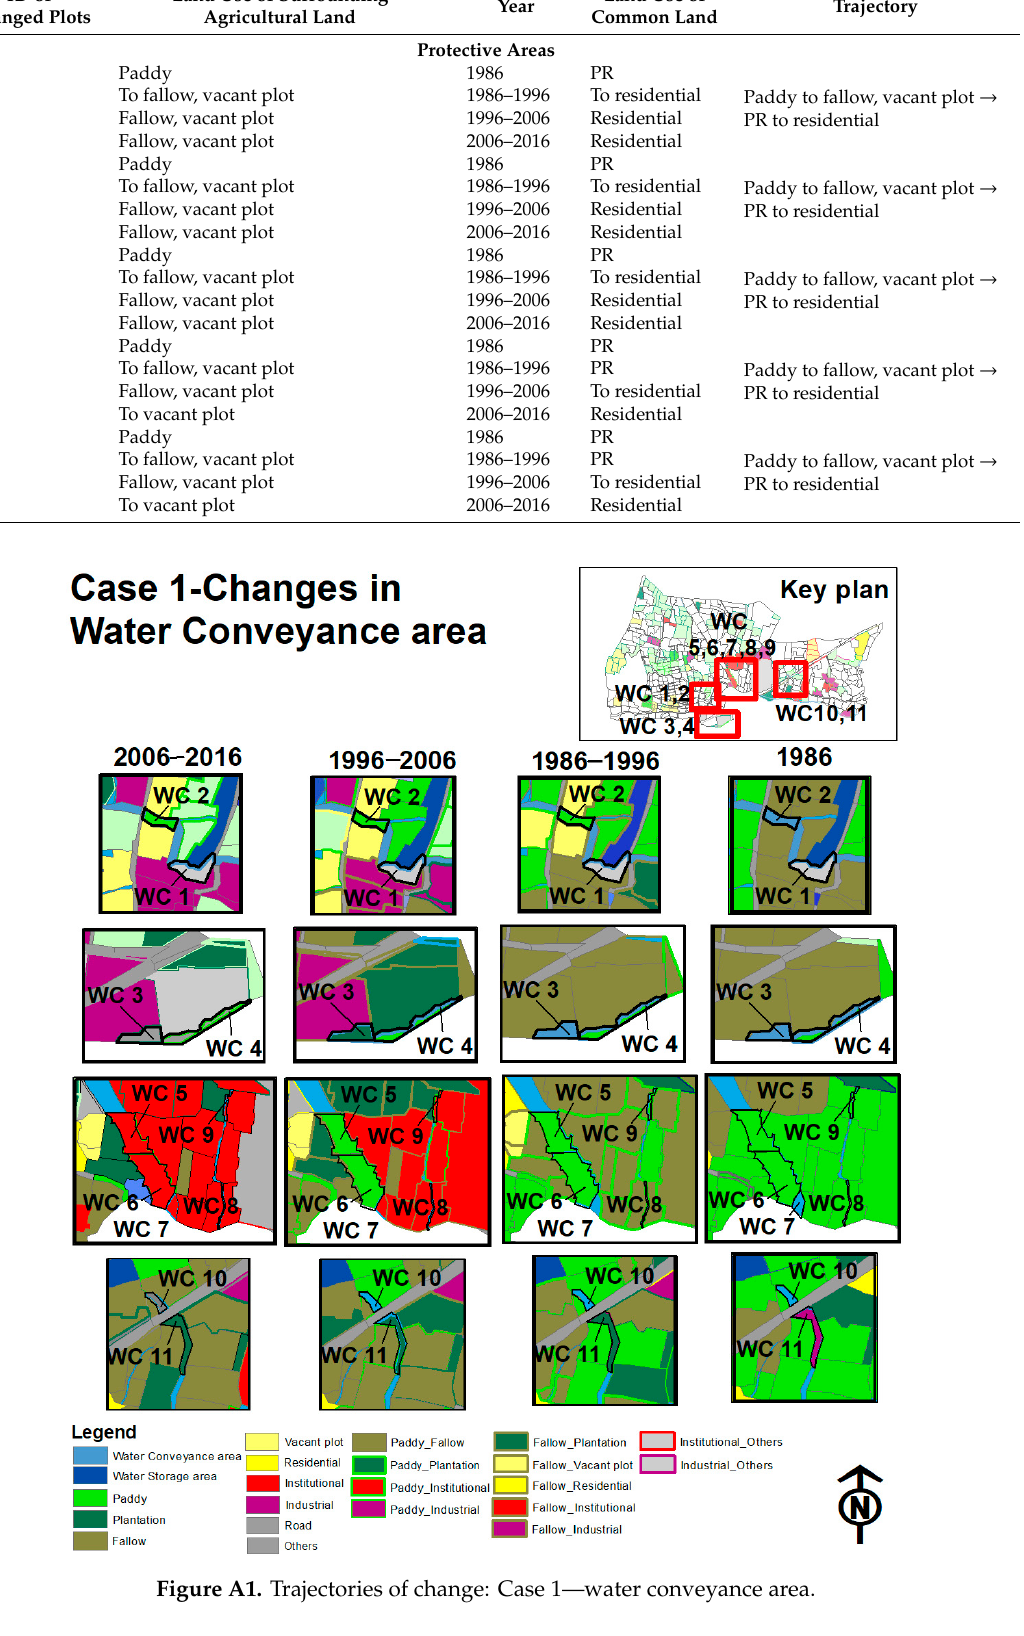
Figure A2. Trajectories of change: Case 1—protective area.